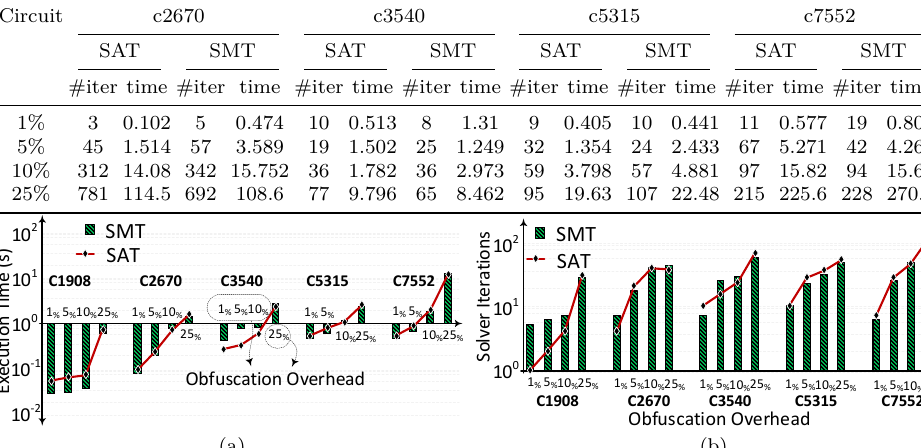
Table 3: Comparing the Execution Time and the Number of Iterations of SMT Attack in SAT Attack mode (Attack Mode 1) with a Pure SAT Attack based on Lingling Solver [SRM15] on ISCAS-85 Benchmarks Obfuscated using Random XOR/XNOR Insertion (RLL) [RKM10] (50%-50%).